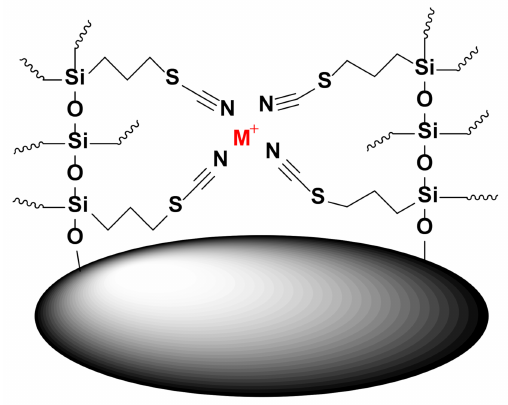
Figure 2. Schematic demonstration of the interaction between 3-thiocyanatopropyl-functionalized sol-gel silica